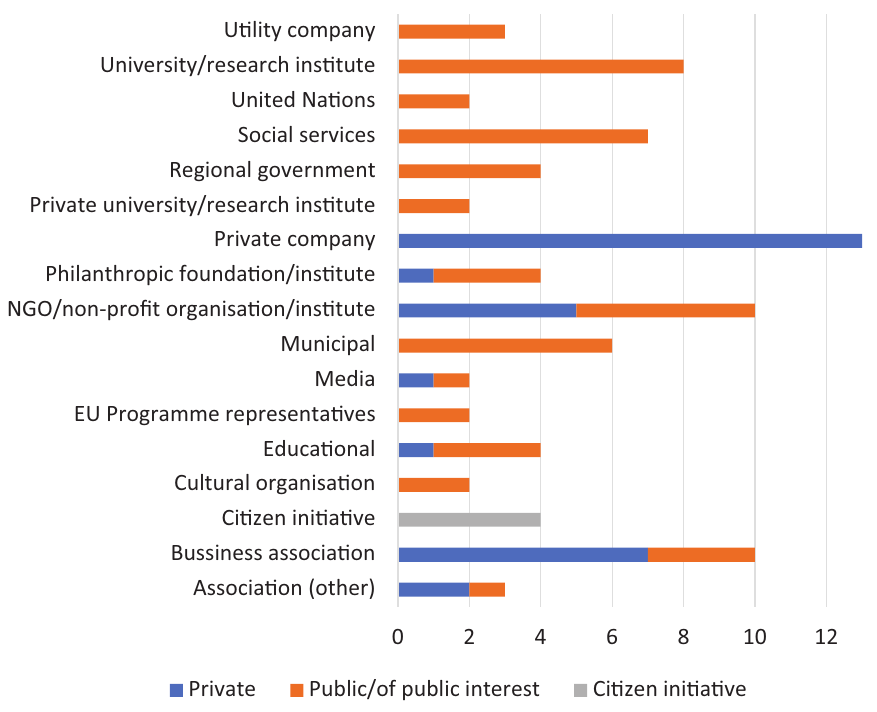
Figure 4. Types of stakeholders involved in the development of the Preliminary Resilience Assessment of MoTh